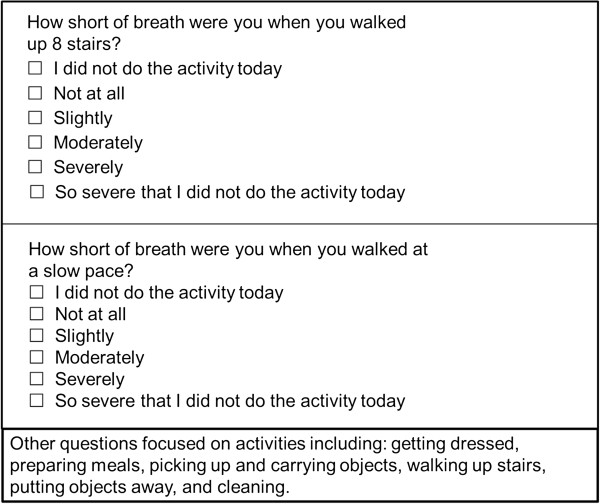
Rationale for item rejection or acceptance in the 37-item pool for the SOBDA questionnaire.